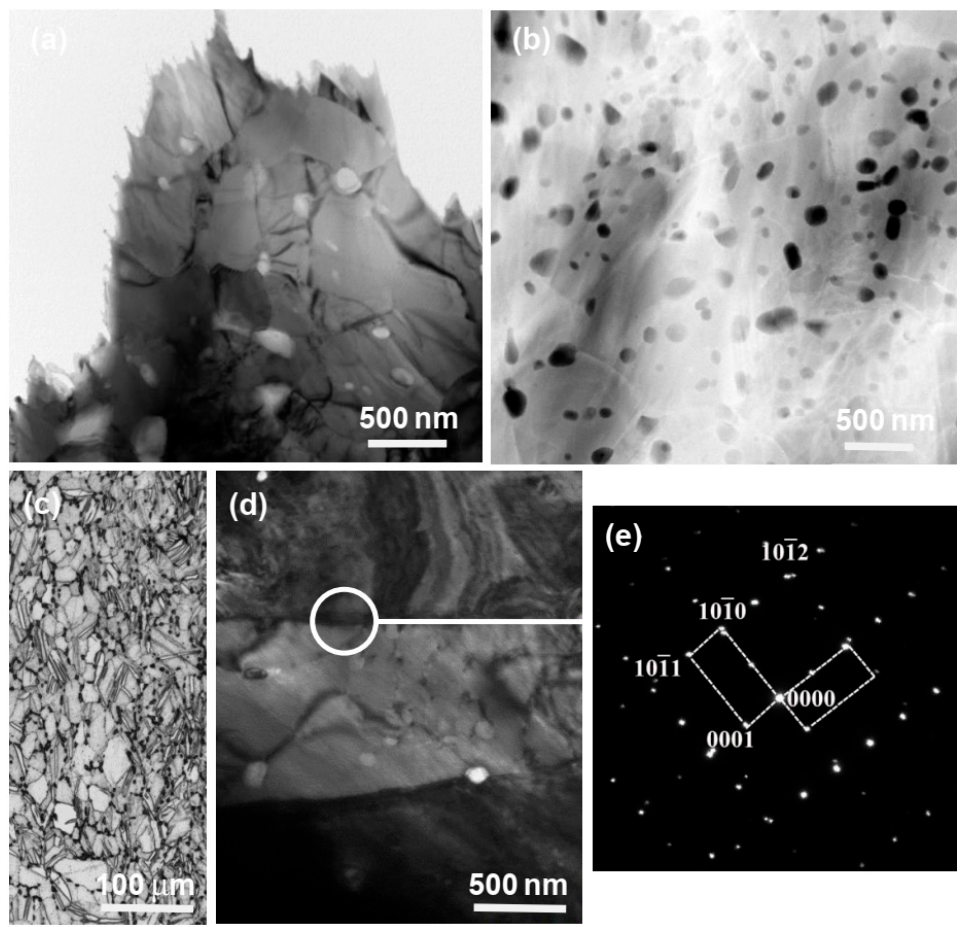
Figure 4. ( a ) Bright and ( b ) dark field images of top layer; ( c ) microstructures of OM and ( d ) TEM micrographs of bottom layer, ( e ) the selected area diffraction patterns at twinning in the selected area of (d).